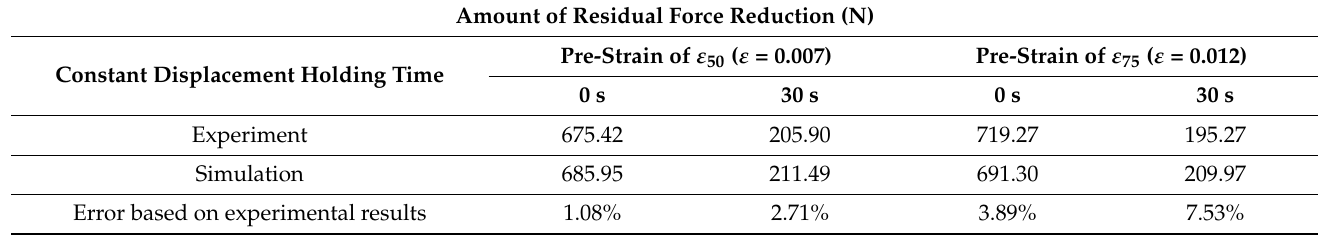
Error based on experimental